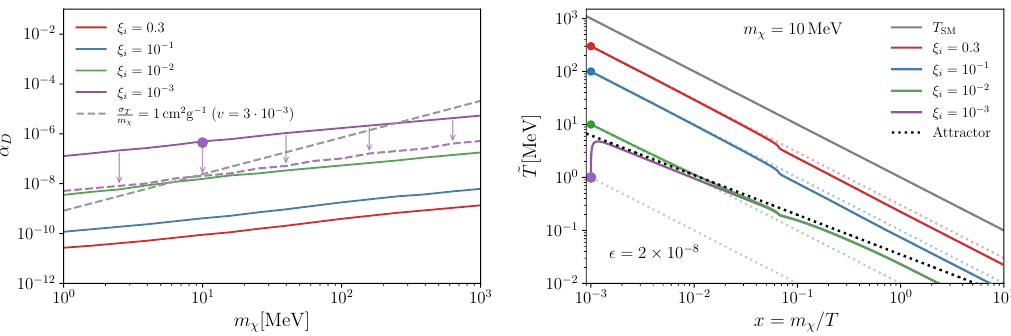
Figure 1 . Left panel : minimum value of α D required for the rapid kinetic equilibration of DM, as a function of m . Solid colored lines show results for a range of fixed initial temperature ratios ξ χ under the (conservative) assumption that the HS temperature evolves adiabatically. For ξ (dashed purple line) we show the case when there is energy injection, i.e. non-adiabatic evolution, which weakens the constraint on α . The dashed gray line shows the maximum value of α D by requiring the DM transfer cross-section σ for self-interactions [79] to satisfy σ T at cluster-scale velocities v = 3 × 10 − 3 [80]. Right panel : solid lines show the evolution of the hidden temperature for α = 1 . 1 × 10 − 7 and (cid:15) = 2 × 10 − 8 (yellow dot in figure 2) for different D initial temperature ratios. Faded dotted lines shows the adiabatic evolution of the HS